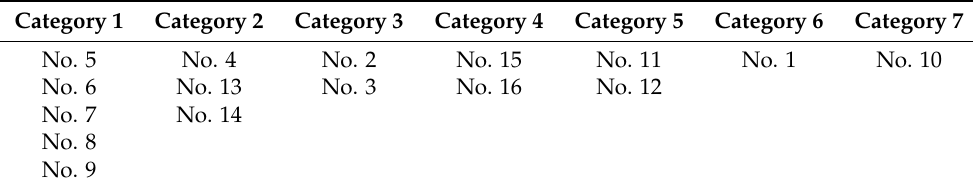
Table 1. Mixed clustering results of observation